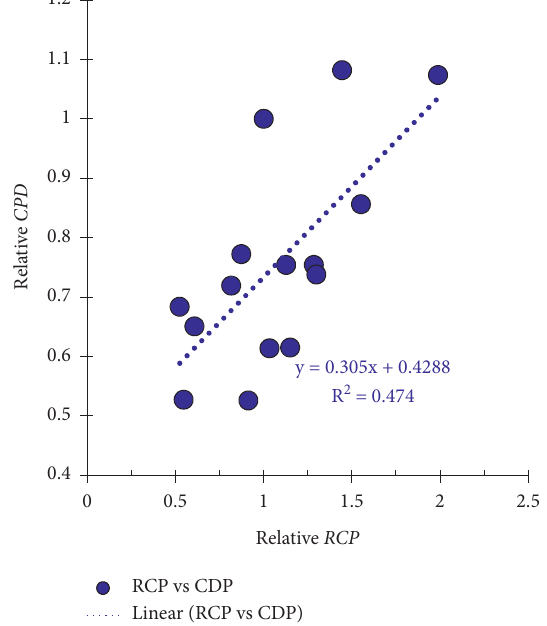
Figure 23: Relationship between CPD and RCP